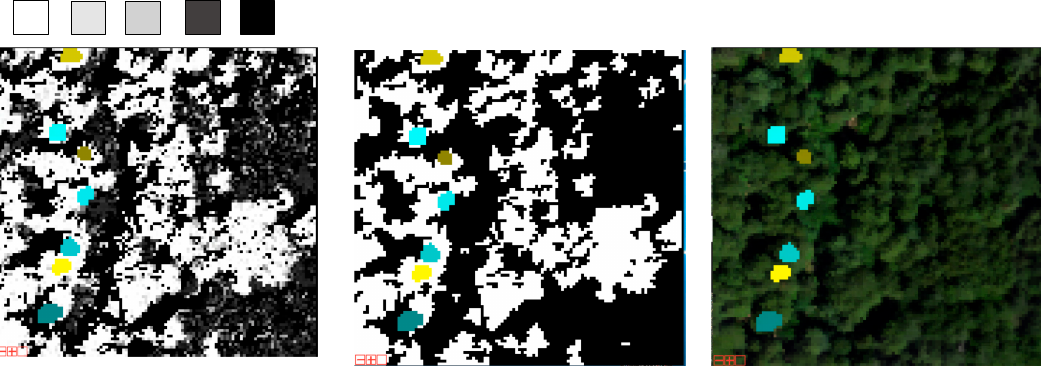
Figure A2. The leftmost panels shows the gradient boosted regression tree (GBRT) output threshold map, with field-collected training and testing data shown in blue, green, and yellow colors. The middle map is the classification map once the threshold and the sieve had been applied, and the right map shows a red, green, and blue composite image of the same location, with the field-collected training and testing crowns shown in blue and yellow. Table A1. Threshold values selected for each site.